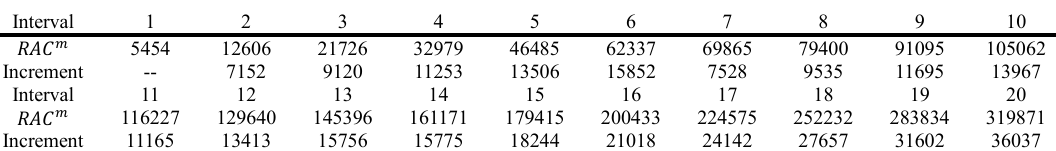
Table 3. Cumulative RAC and the cost increment of each interval